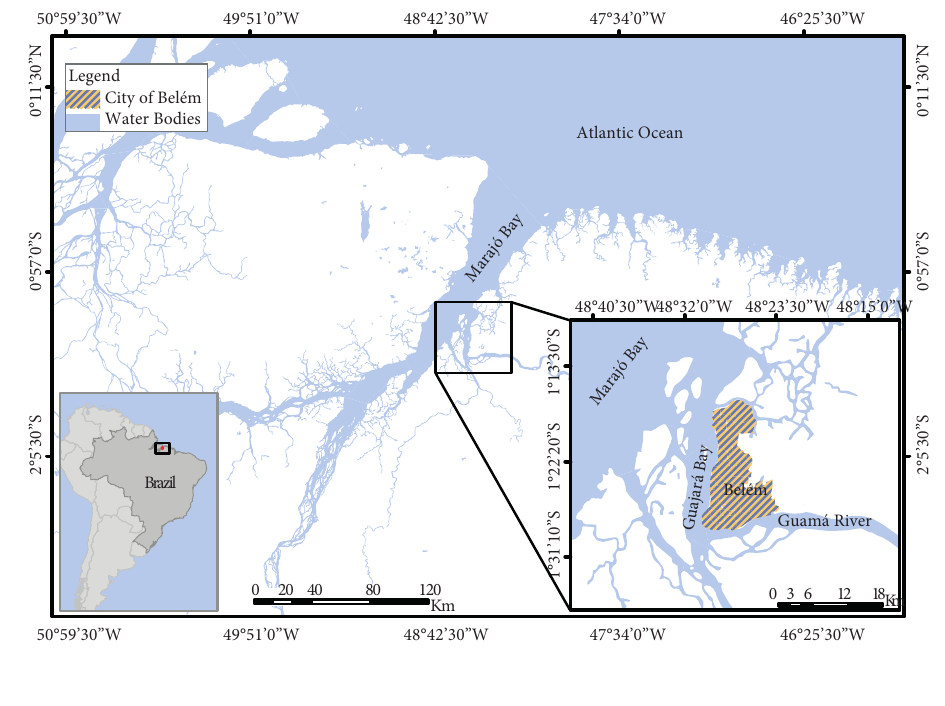
Figure 1. Map of the study